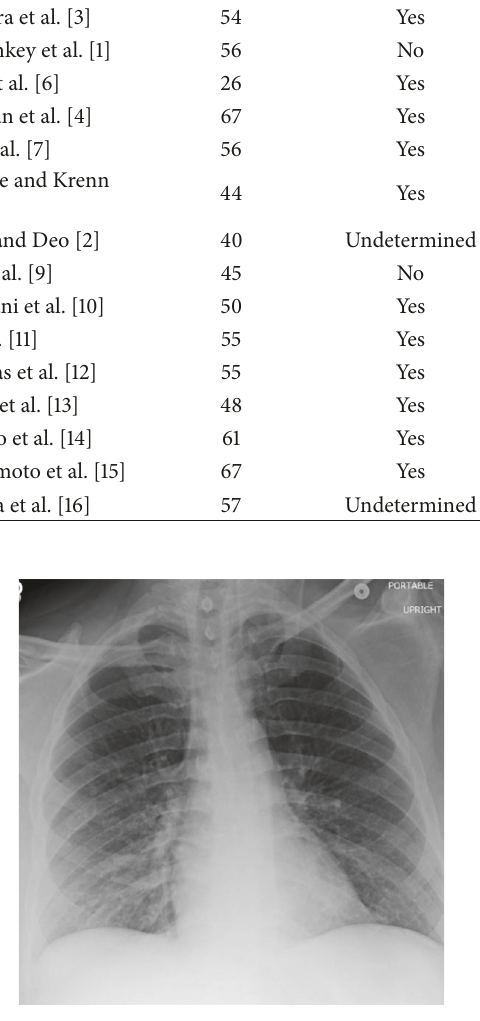
Figure 4: CXR after three-week follow-up, without consolidation.